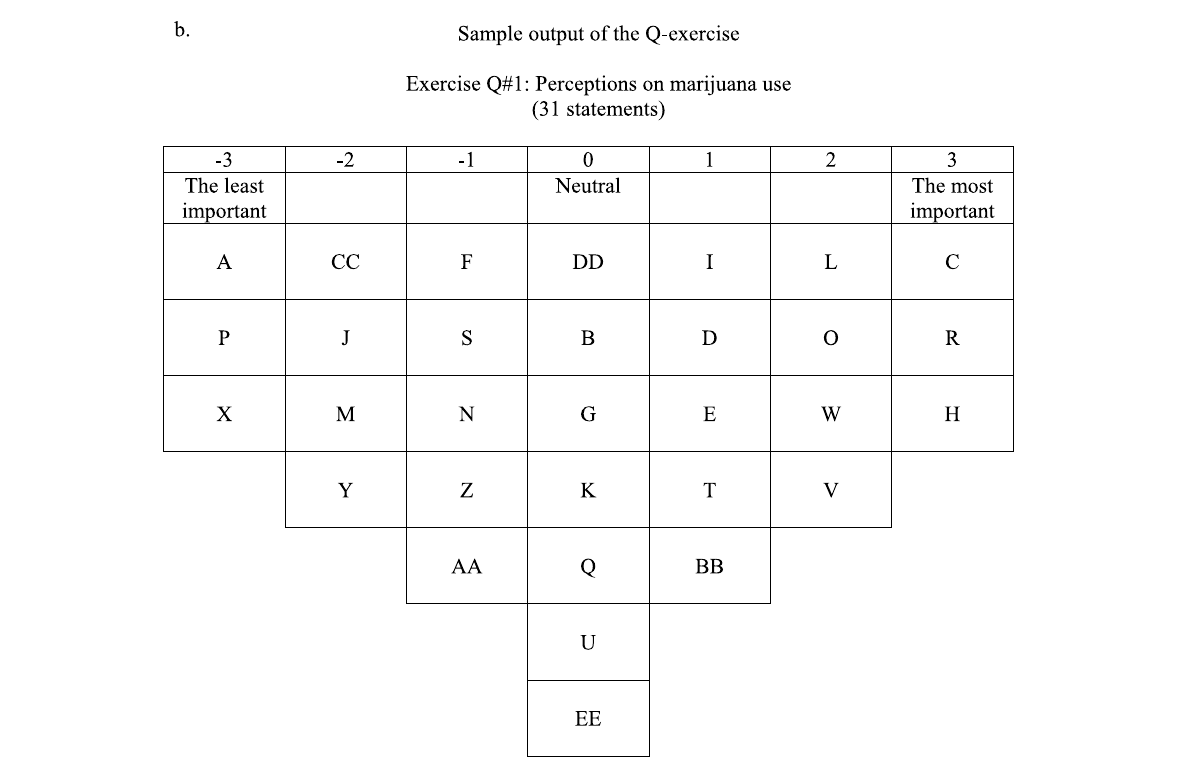
Fig. 1 a , b Q-sort dynamic at a glance. a Sample template for the Q-sort exercise. b Sample output of the Q-exercise. Source: Espinosa